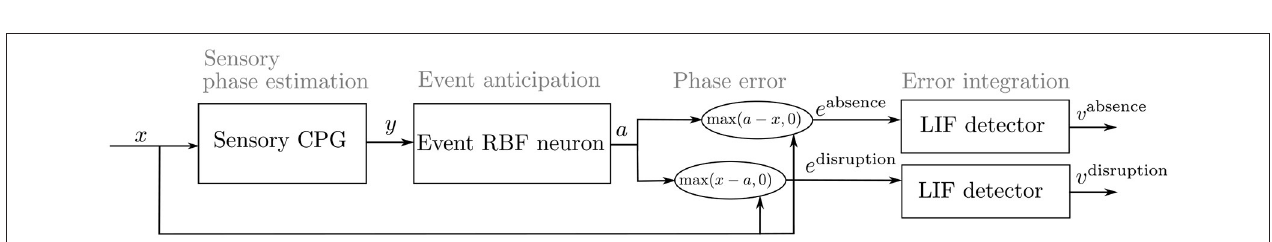
FIGURE 3 | The proposed gait controller architecture takes the sensory signal x as the input and outputs the control signal u . The gait controller is composed of two sub-controllers: (i) Phase Control, which detects the mistiming and regulates the phase of the gait, and (ii) Amplitude Control, which maps the motor phase φ u and mistiming detections v into actuator commands u . The phase control is CPG-based, where a coupled ensemble of CPGs estimates the sensory phase φ x and generates the motor phase φ u . The mistiming detector compares the sensory phase estimation φ x to sensory input x , and self-learns to detect sensory phase errors v . The mistiming detection v and generated motor phase φ u flow into the amplitude control, which transforms the inputs into the control signal u . There are two modules of the amplitude control: the regular control and the reflex control that modifies the regular control if triggered by mistiming detection.